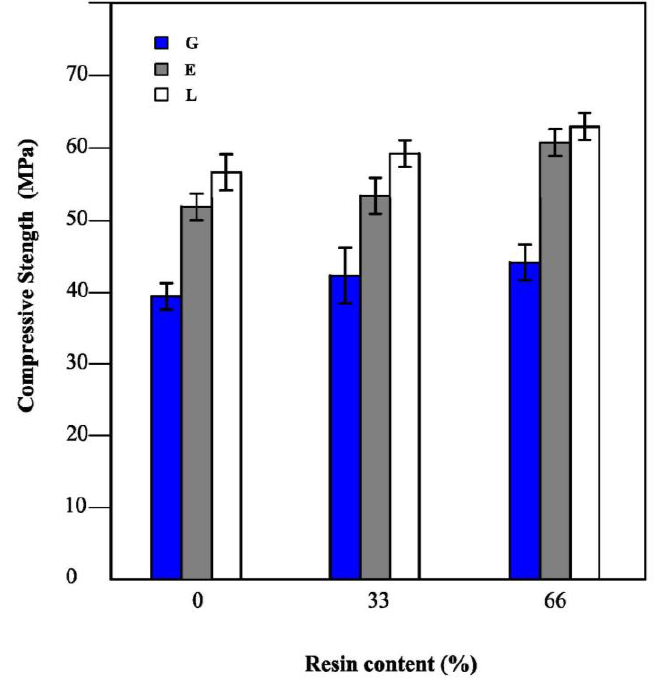
Figure 6. Compressive strength of G, E, L specimens as function of sand